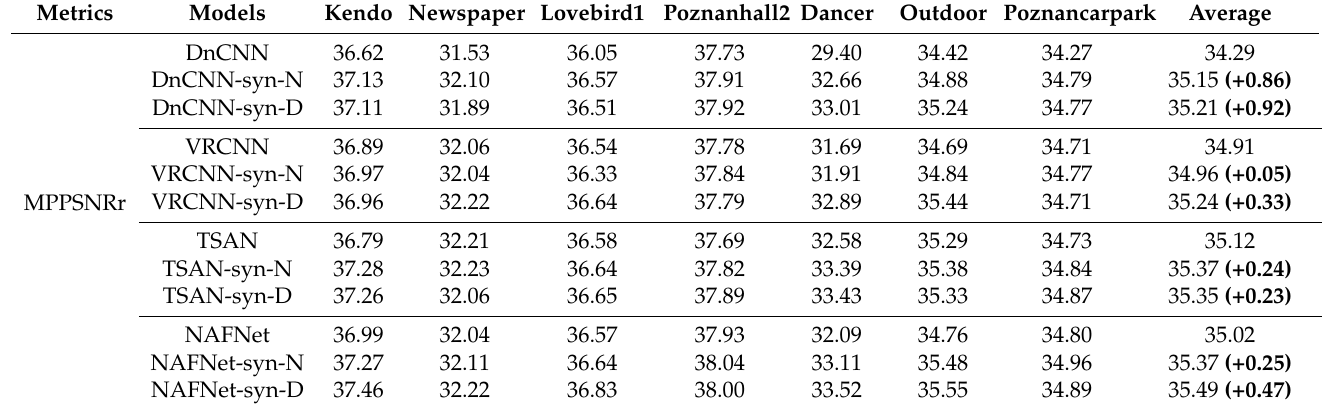
Table 7. SVQE comparison measured by SVI metrics among DnCNN-, VRCNN-, TSAN-, NAFNet- based schemes by pre-training on synthetic databases from NYU and DIV2K on Seqs-H.264. Model (DnCNN, VRCNN, TSAN, NAFNet) represents the baselines, and model-syn-N/D represents the existing models (DnCNN, VRCNN, TSAN, NAFNet) combined with transfer learning scheme using our proposed synthetic images. The performance gains of the proposed model-syn-N/D over model are highlighted in